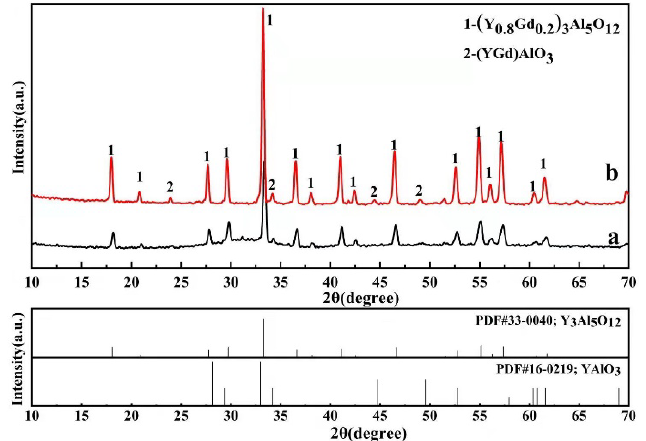
Figure 5. XRD patterns of GYAG coatings before and after heat treatment: ( a ) as-deposited state; ( b ) heat-treated state at 1350 °C for 5 h.